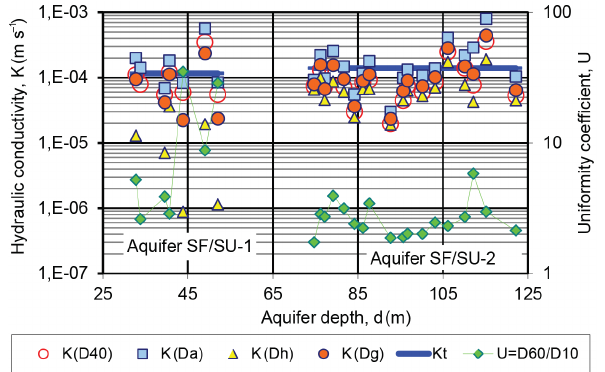
Figure 7. Predicted hydraulic conductivity calculated using the KC equation for samples from sandy aquifers with thin silty intercala- tions.